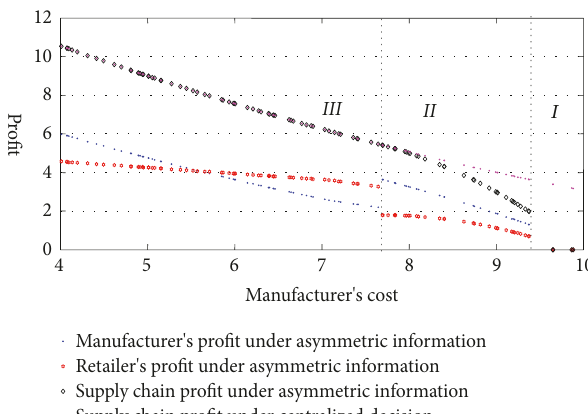
Figure 10: The relationship between profit and manufacturer’s cost (for 𝑐 𝑟 = 3